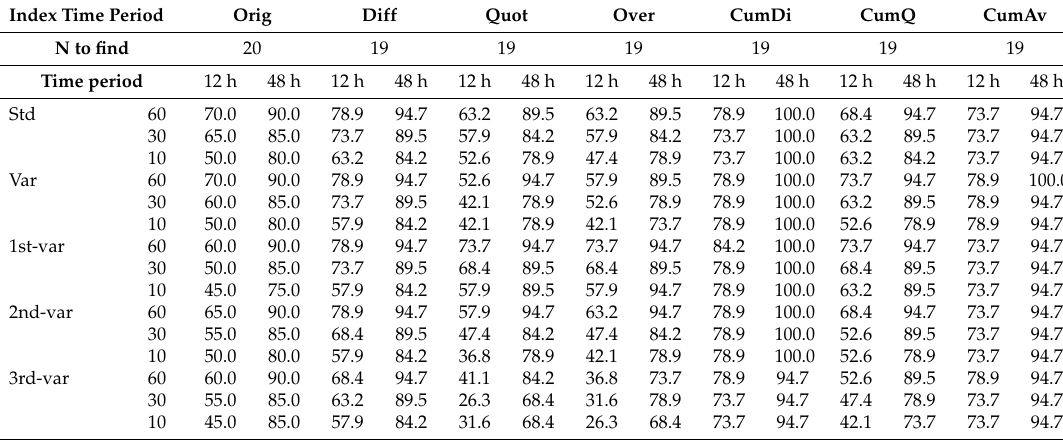
Table 1. Maximal frequency of sows detected (%) for the onset of farrowing within 12 or 48 h before the onset of farrowing (first alarm for each sow) per type of acceleration index (Orig, . . . CumAv), distribution characteristic (Std, . . . 3rd variation), and time period (10, 30, 60 min) for parameterization period of Day − 4 independent of the interval length of the moving average and the k and h values. Bold font indicates the best performance.